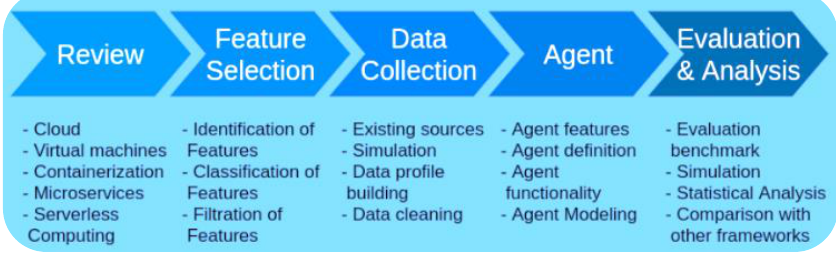
Figure 6. Research methodology flow.